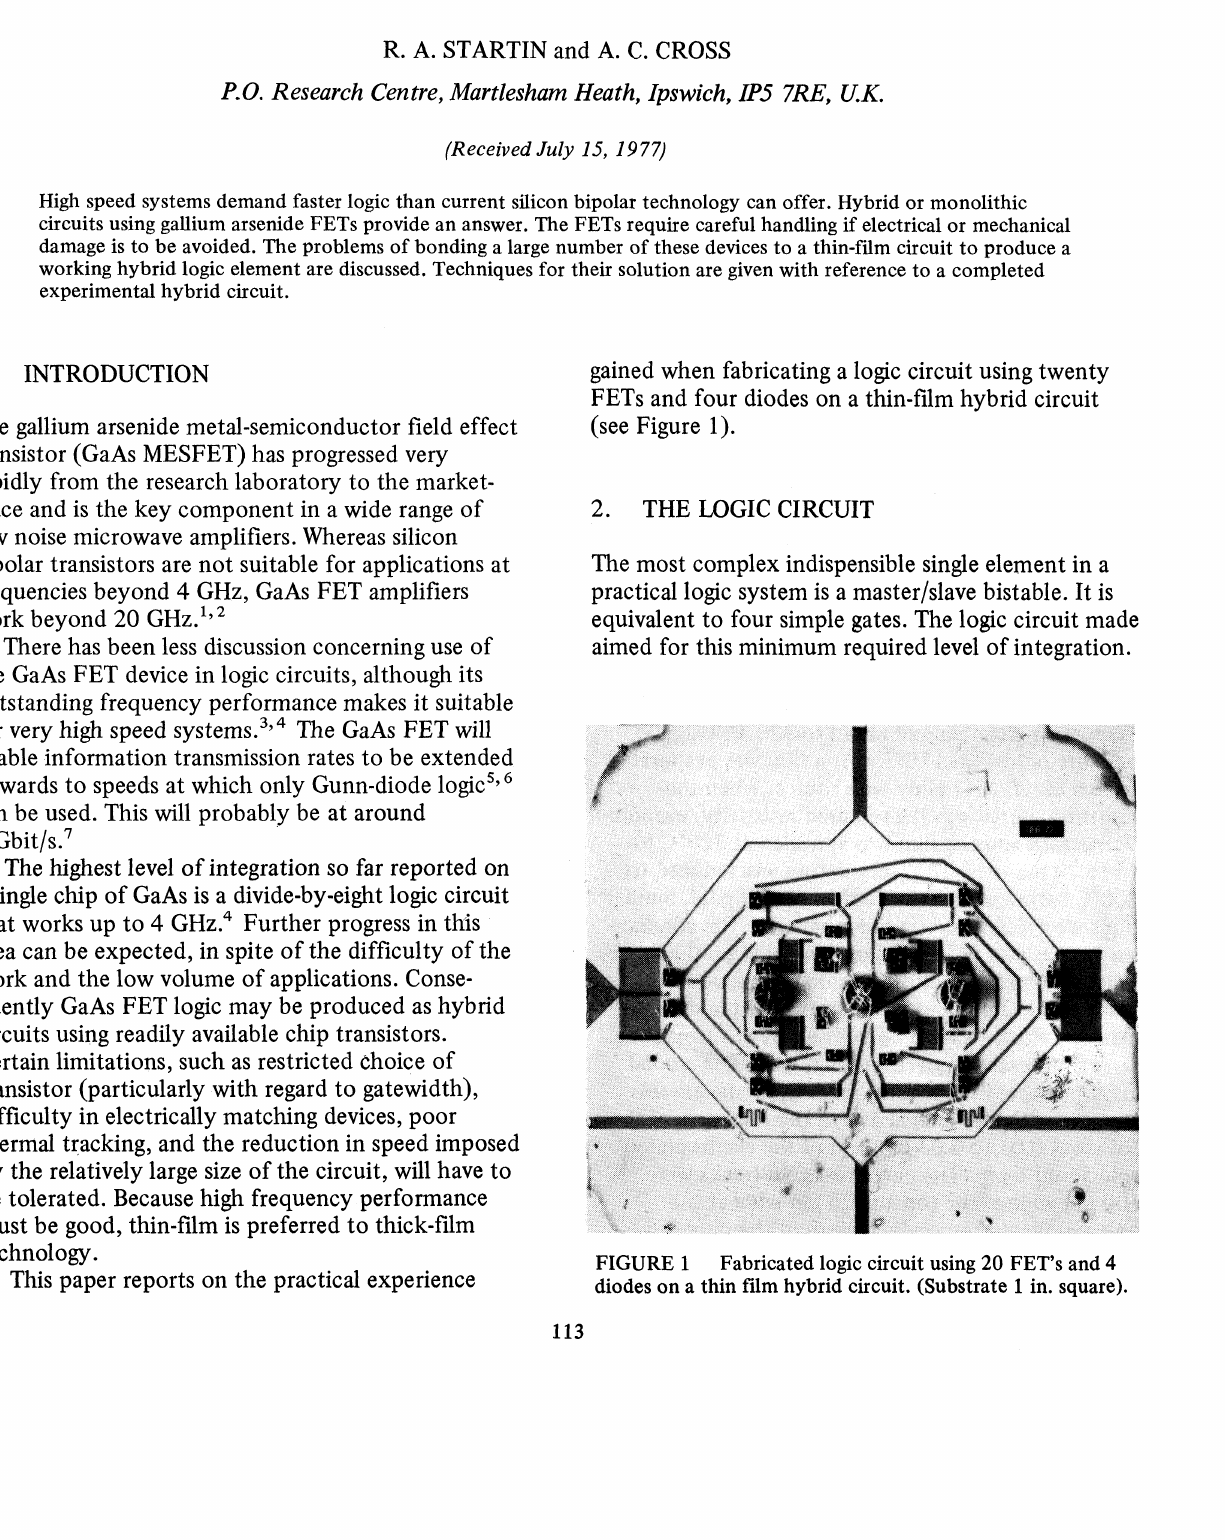
Fabricated logic circuit using 20 FET’s and 4 diodes on a thin film hybrid circuit. (Substrate in.